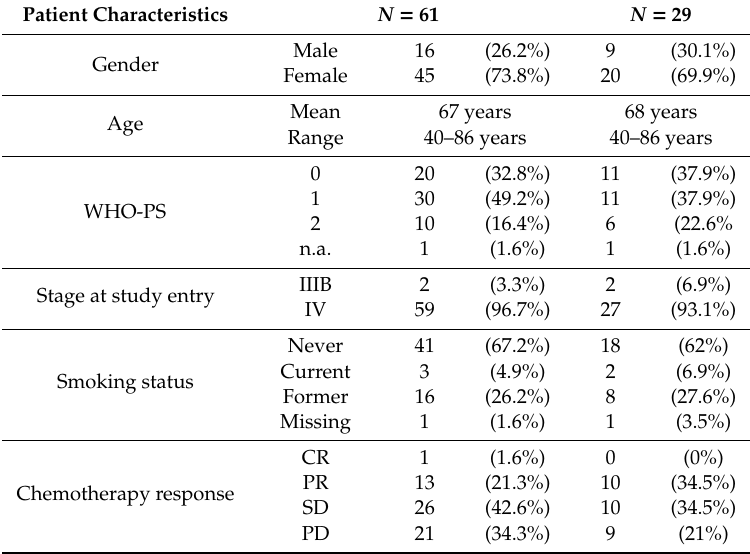
Table 1. Clinical and pathological feature of the 29 patients included in the serum-derived circulating cell-free DNA (cfDNA) analysis as compared with the 61 patients enrolled in ICARUS